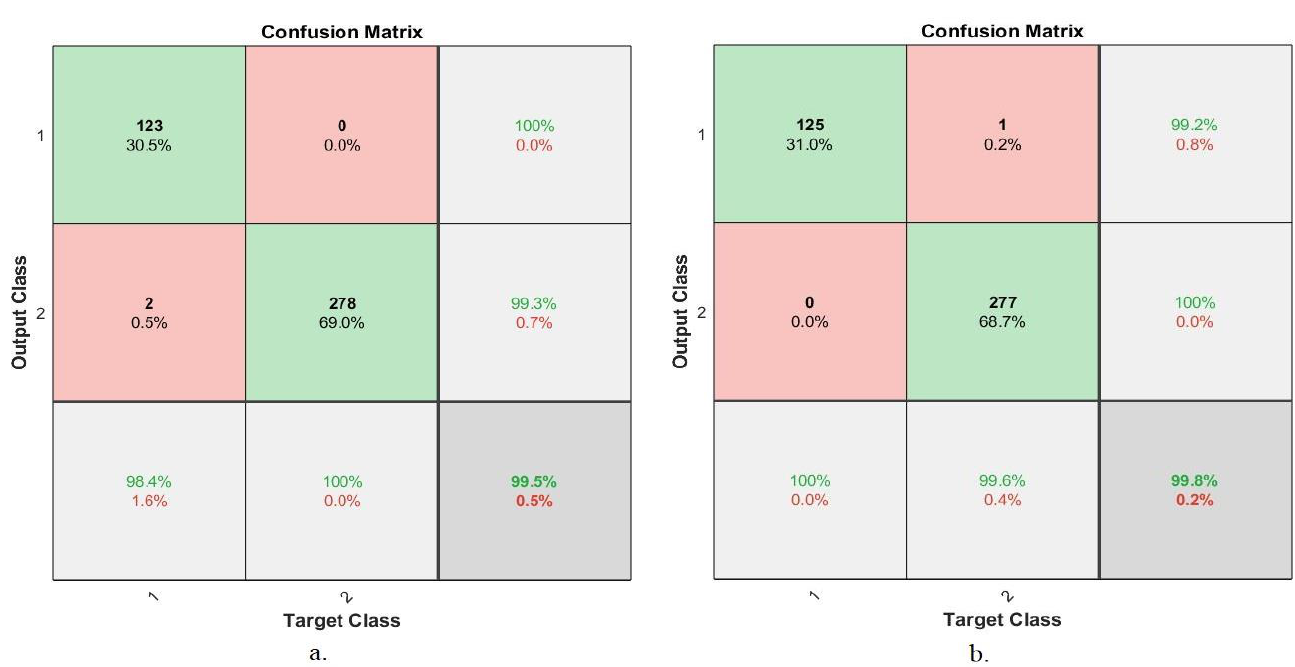
Figure 13. Confusion matrix for ANN for classifying a 200× dataset based on fusion features by ( a ) AlexNet with FCH, LBP, and GLCM and by ( b ) GoogLeNet with FCH, LBP, and GLCM.